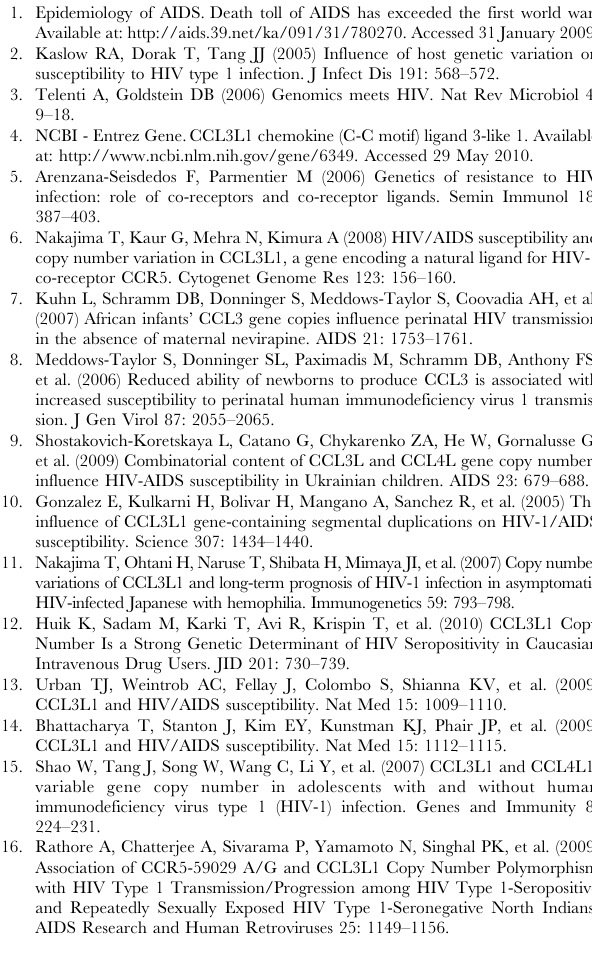
Figure S1 Sensitive test of the GCN # PMN Vs. GCN . PMN model. (TIF) Figure S2 Sensitive test of the GCN , PMN Vs. CCL3L1 GCN $ PMN model. (TIF) Table S1 Characteristics of studies included in the